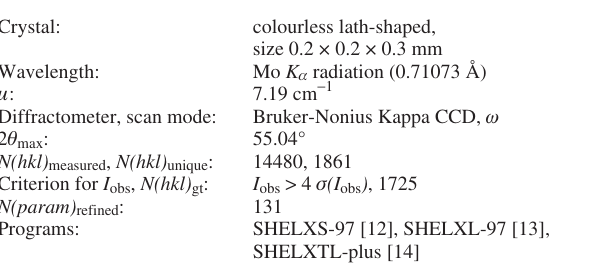
Table 1. Data collection and handling.